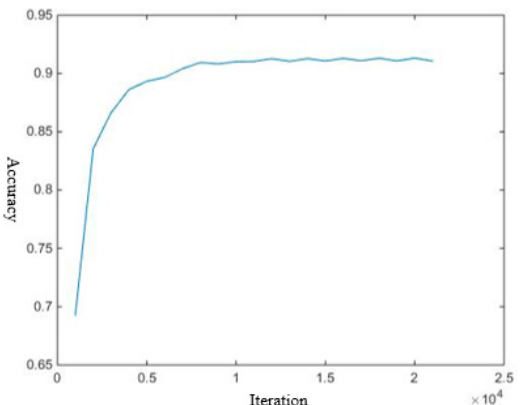
Figure 3. The change curve of accuracy according to iteration during training process of NCA-net.